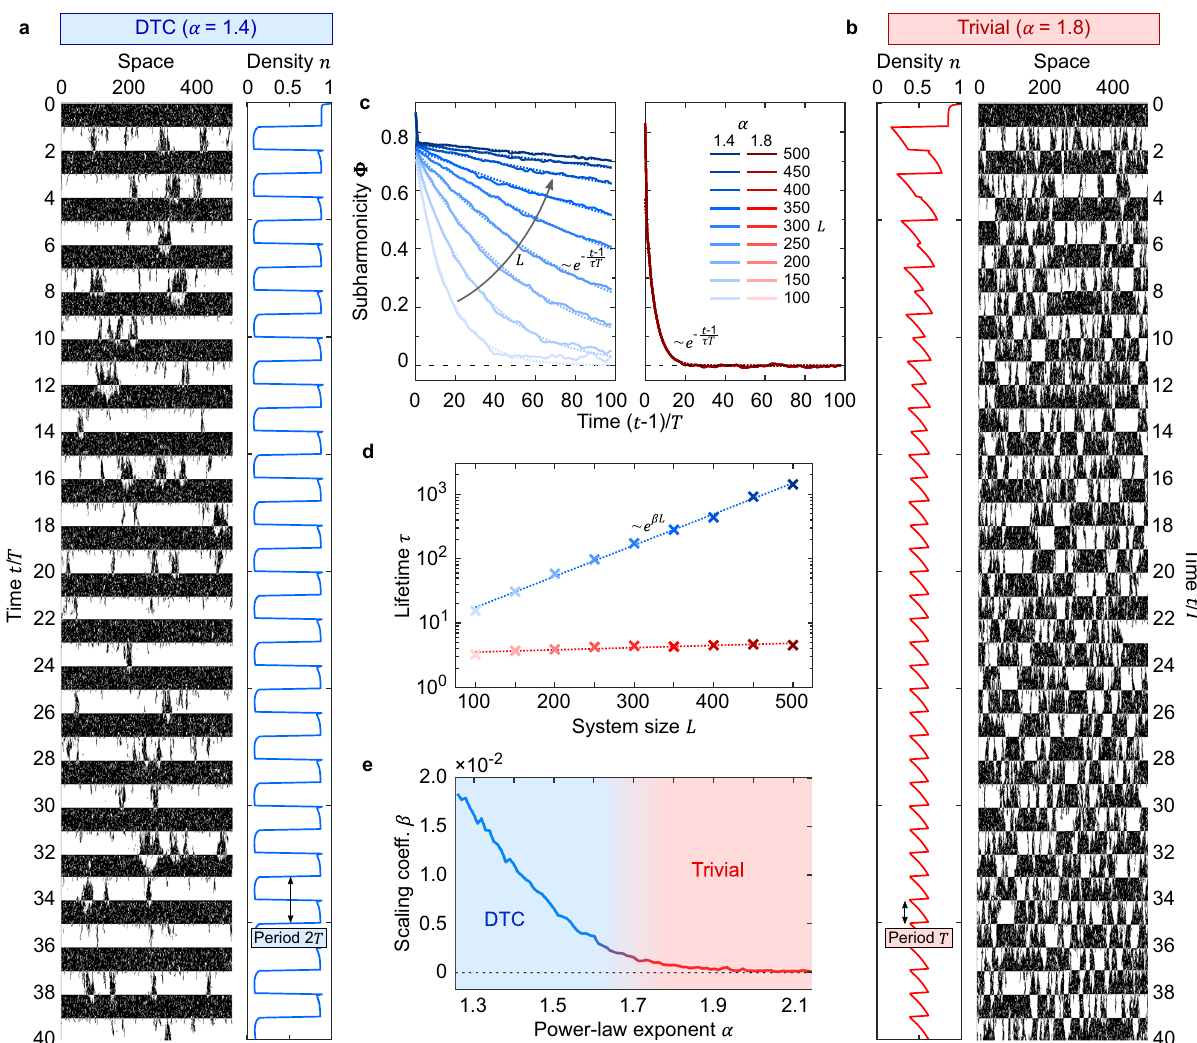
Fig. 3 Discrete time crystals in driven long-ranged directed percolation. a , b Single instances of the periodically driven DP, alongside with the density n averaged over multiple independent runs, for L = 500 sites. a For a power – law exponent α = 1.4, n oscillates subharmonically with a period that is twice that of the drive, whereas, for α = 1.8, n eventually picks the periodicity T enforced by the drive. c For fi nite system sizes L , the subharmonicity Φ ( t ) decays as Φ ð t Þ (cid:3) exp ð(cid:2) t (cid:2) 1 τ T Þ due to the accumulation of phase slips, and, after a few time scales τ T , the density n synchronizes with the drive and oscillates with period T . Exponential fi ts (dotted lines) can be used to extrapolate the lifetime τ of the subharmonic response, on which a scaling analysis is performed in d . For α = 1.4 (blue), the lifetime τ scales exponentially with the system size, τ ~ e β L , whereas no such a scaling is found for α = 1.8. The scaling coef fi cient is again found from an exponential fi t (dotted line) and plotted in e versus the power – law exponent α . For small α , that is, long-ranged enough DP, the scaling coef fi cient β is fi nite, indicating that in the thermodynamic limit L → ∞ the subharmonic response is persistent and a DTC with in fi nite autocorrelation time emerges. On the contrary, β ≈ 0 for large α , indicating a trivial dynamical phase in which no stable subharmonic dynamics is established. Here we considered p 1 = 1, μ = 0.9, p d = 0.02, T = 20 and R =